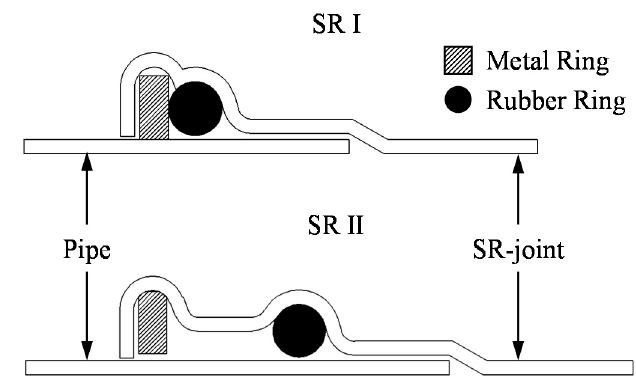
Figure 2. Schematic diagram of SR-joint.